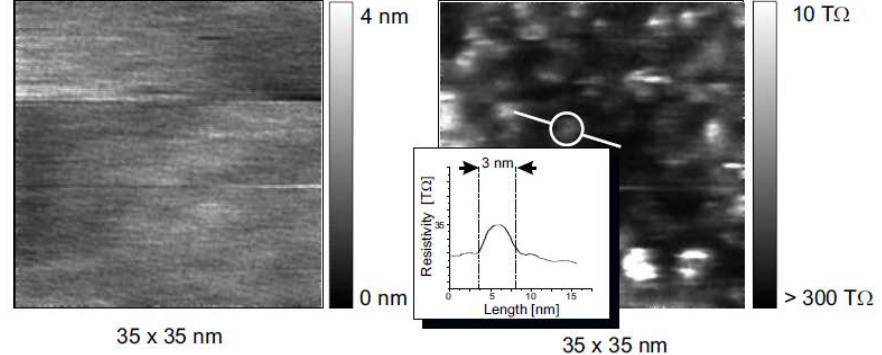
Figure 35. Topography (left) and resistance (right) measured on SrTiO 3 (100) crystal using LCAFM. Adapted from [230].